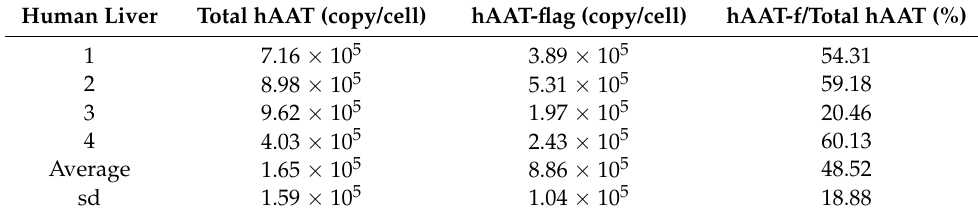
Table 4. Expression of hAAT-flag in human liver segments after hydrodynamic gene transfer. Preliminary results of hAAT-flag protein expression in human liver tissue after the hydrodynamic delivery of its gene. The first column of the table shows the number of human liver segment (HL1-4), second column indicates the total amount of hAAT protein in liver tissue (including hAAT and hAAT-flag) expressed in copy number per cell. The third column shows the specific amount of hAAT-flag protein. The fourth column represents the ratio between the amount of hAAT-flag protein respect to the total amount of hAAT as